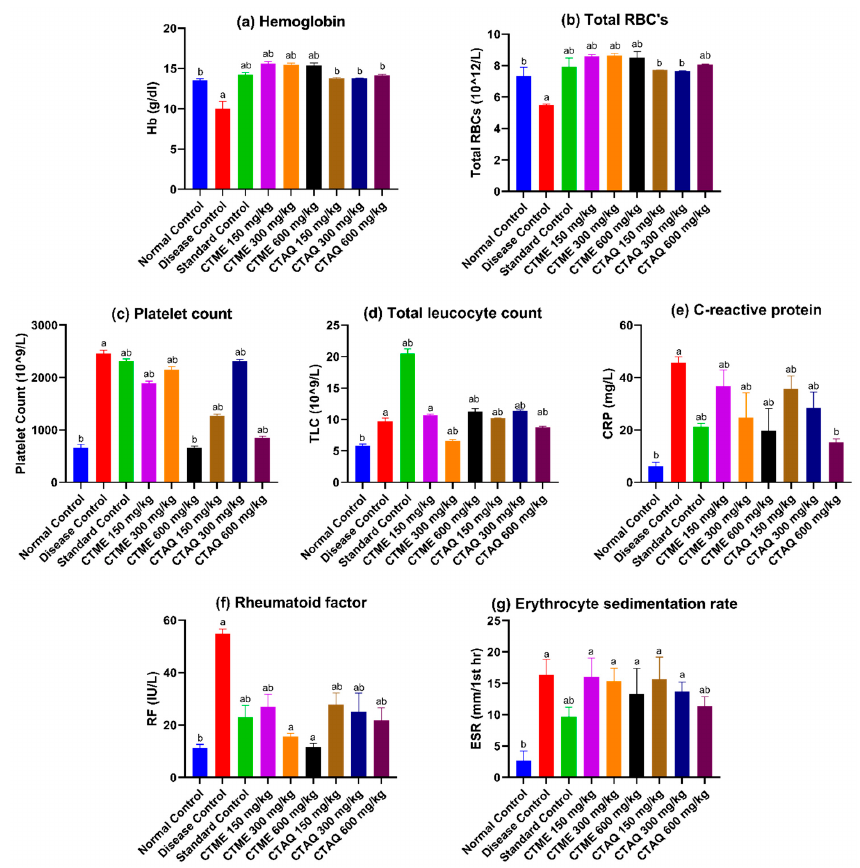
Figure 5. Influence of C. tuberculata extracts on hematological parameters. Data as mean ± S.D and considered significant as compared to a and b. Where a: NCG; b: DCG. The systemic biomarkers like CRP (45.6 ± 2.25 mg/L) and RF (54.93 ± 1.72 IU/L) were increased significantly in the disease group in contrast to the normal group as shown in Figure 5e, f. However, treatment with CTME, CTAQ and methotrexate (CRP: 21.27 ± 1.27